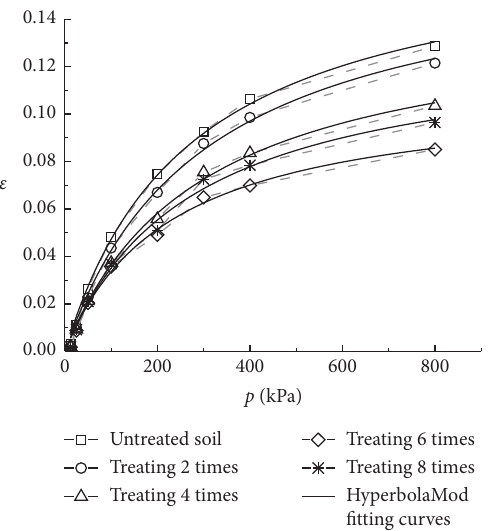
Figure 5: Relations between ε and p